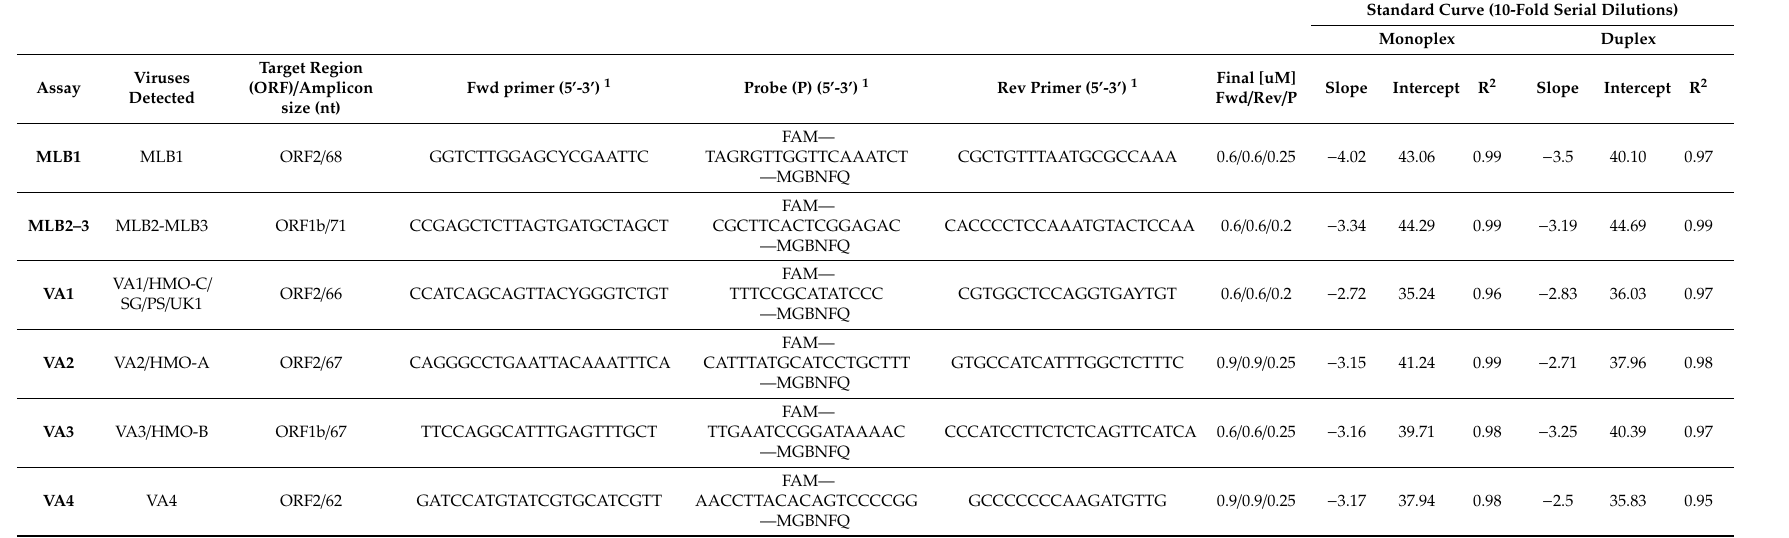
Table 1. Nucleotide sequences of the primers and probes used and standard curves parameters of the novel HAstV real-time RT-PCR